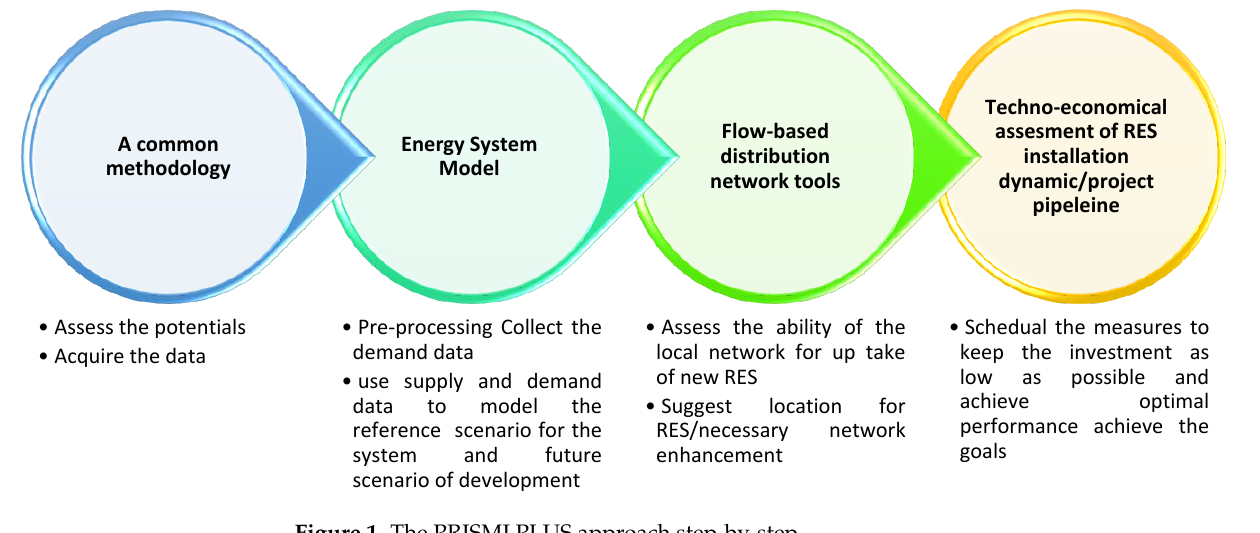
Figure 1. The PRISMI PLUS approach step-by-step.